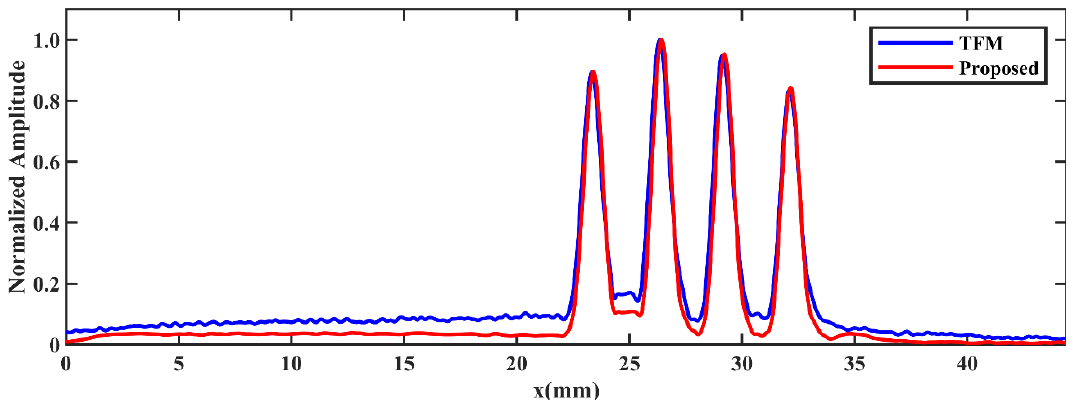
Figure 7. Experimental results reconstructed by TFM and proposed method. ( a ) The image reconstructed by TFM. ( b ) The image reconstructed by the proposed method. ( c – f ) The local enlarged images of the four SDHs in the result of TFM from left to right, respectively. ( g – j ) The local enlarged images of the four SDHs in the result of proposed method from left to right, respectively.